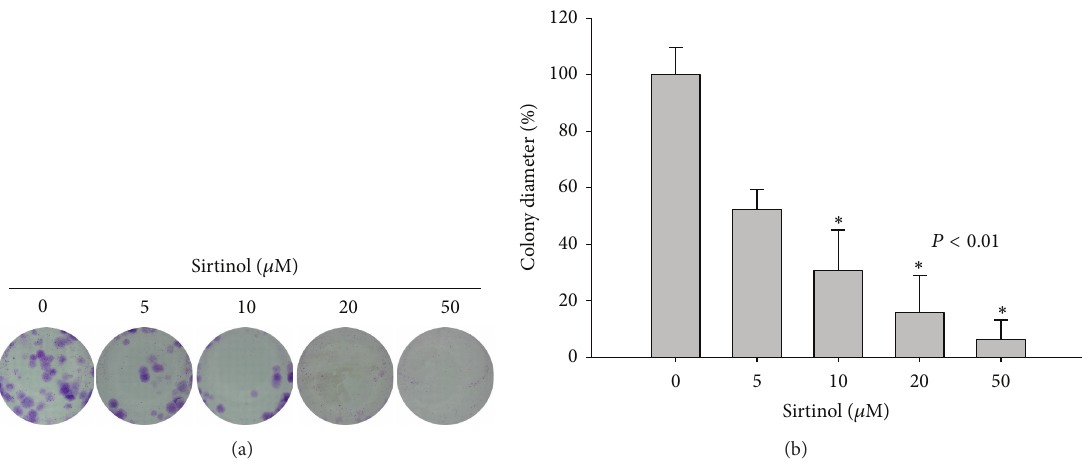
Figure 2: Sirtinol inhibits the colony formation of lung cancer cells. H1299 cells were treated with different concentrations (5, 10, 20 and 50 𝜇 M) of sirtinol for 15 days, respectively. Afterwards, the cells were glutaraldehyde-fixed and stained with Giemsa stain for 1h. (a) The colony formation analysis of H1299 cells. (b) The quantification analysis of the colony diameter. Data are represented as mean ± SD ( 𝑛 = 3 ). ∗ 𝑃 < 0.01 compared with the vehicle control.